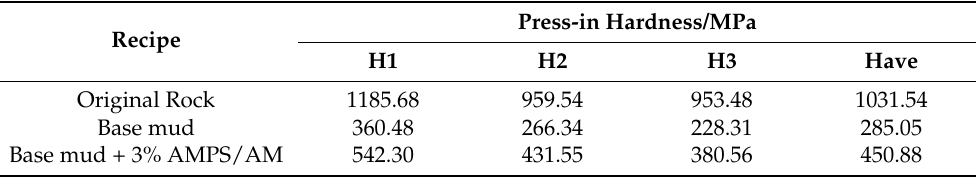
Table 1. Hardness test results of cores before and after replacement.